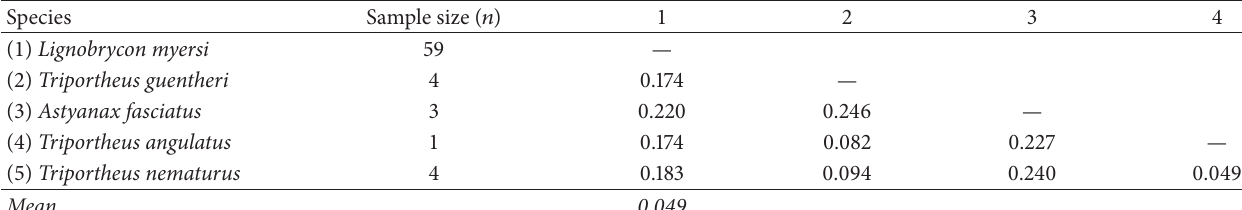
Table 2: Interspecific genetic distances of COI sequences based on K2P model.